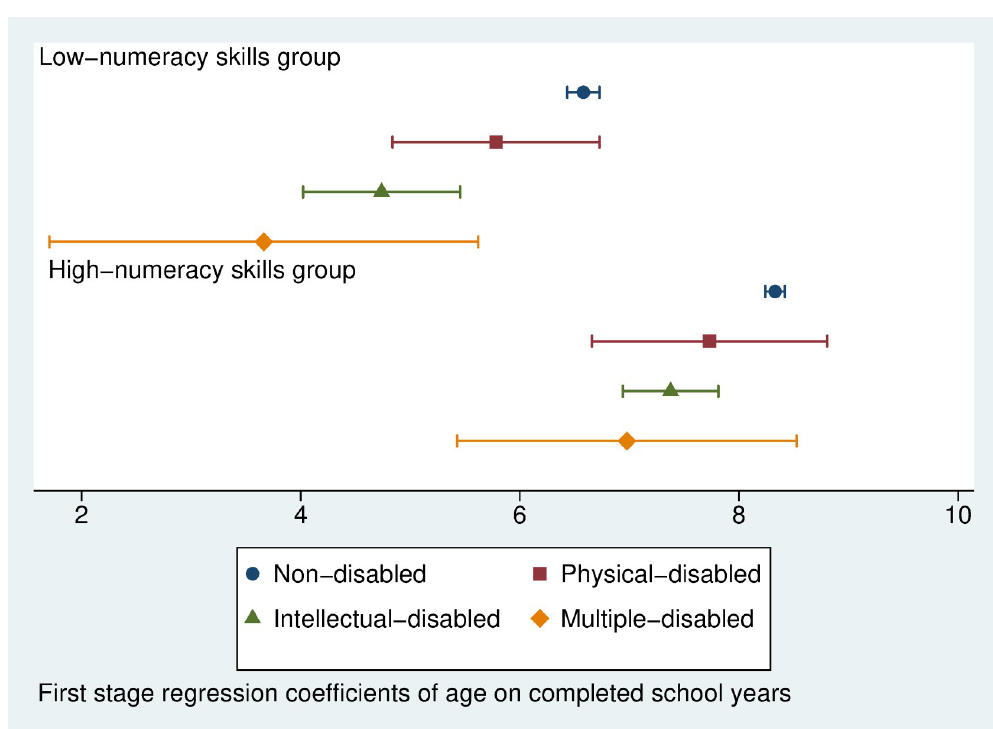
Fig 5. First-stage regression coefficients of age on completed school years with 95% confidence intervals (IV regression on numeracy skill return to each completed school year, separate IV models for three disability types in low- and high- numeracy skills country